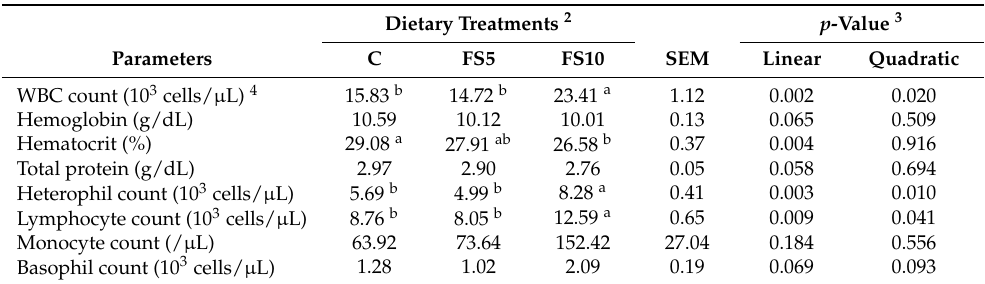
Table 5. Effect of the dietary fenugreek seed (FS) inclusion on the hematological parameters of the broiler chickens 1